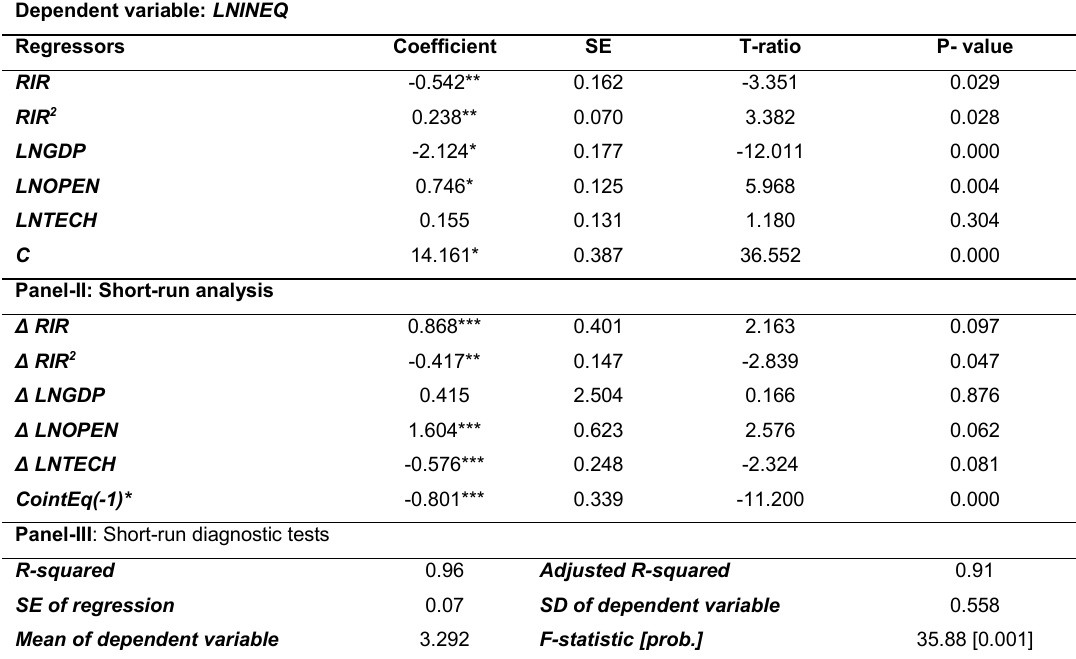
Table 5. Estimated long- and short-run coefficients using the ARDL